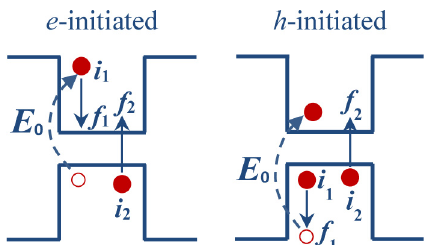
Figure 4. Schematic representation of the electron- ( left ) and hole-initiated ( right ) process of multi- exciton generation in a nanocrystal. Initial electron configurations are shown. Dashed arrow indicates highly excited exciton with the excitation energy E 0 created by an absorbed photon. Vertical solid arrows indicate electron transitions to the final states. After the transition, the number of excitons increases by